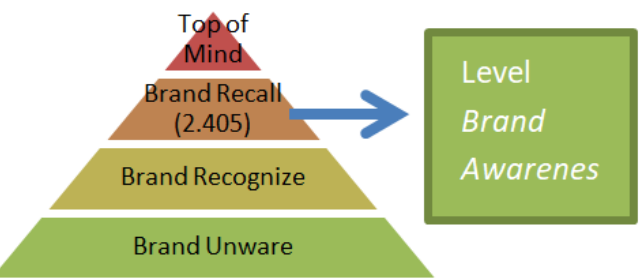
Figure 2. Level of Local Community Brand Awareness on tourism branding in Samosir